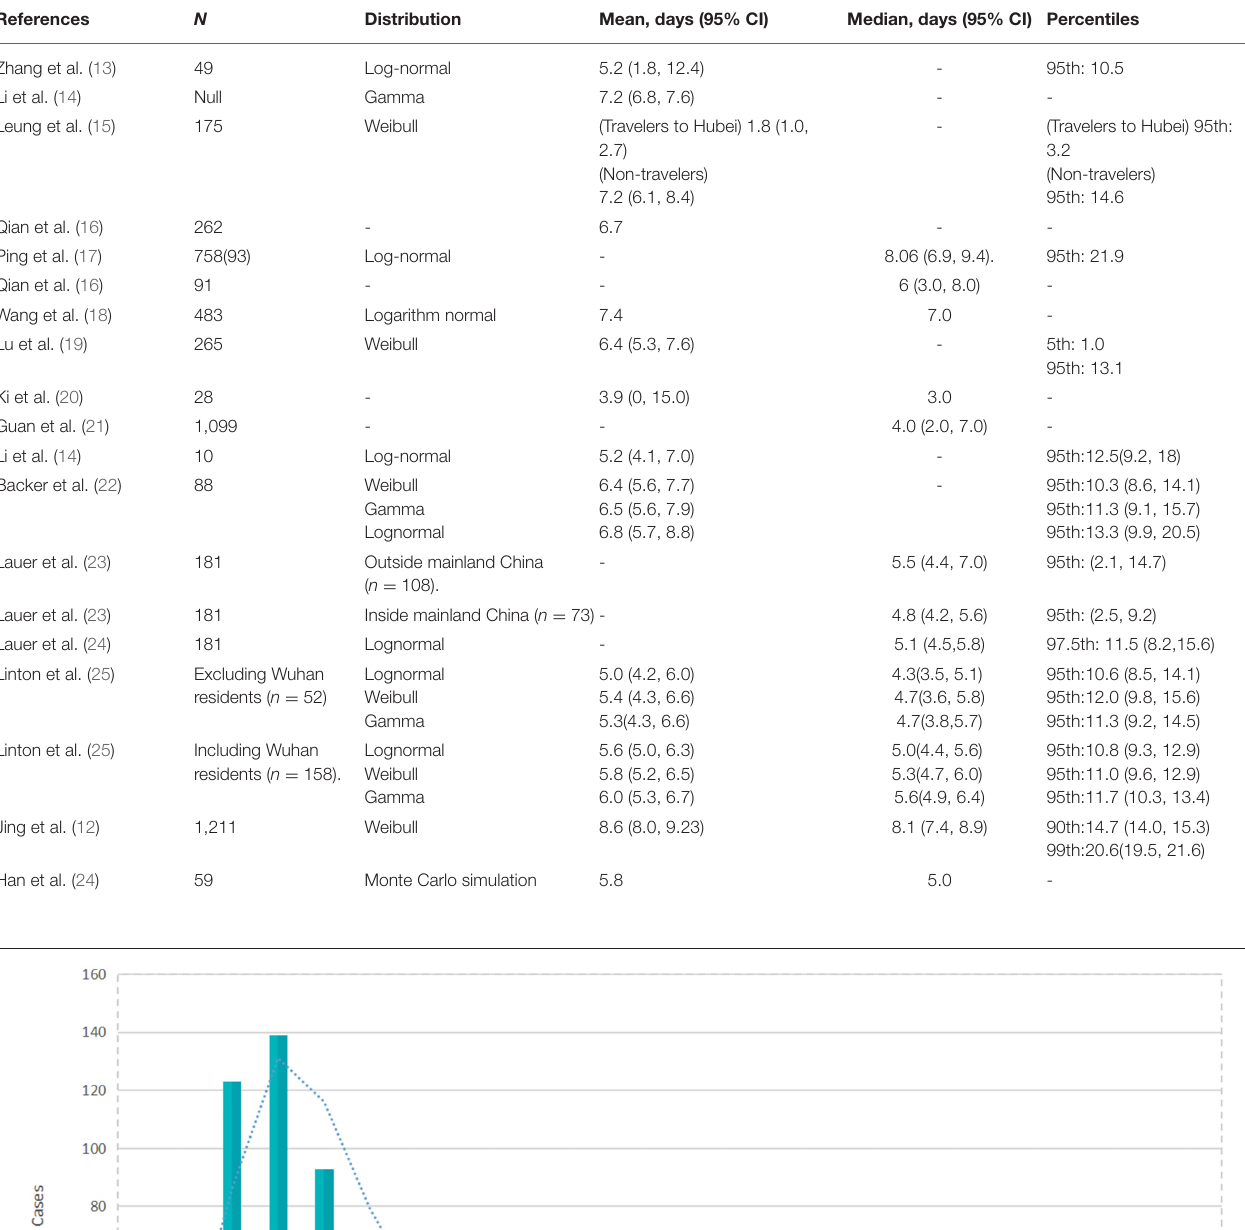
TABLE 3 | Study list of incubation period of COVID-19 estimation.